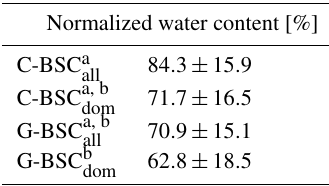
Table 1. Water content at which net photosynthesis is below 75% of maximum net photosynthesis including